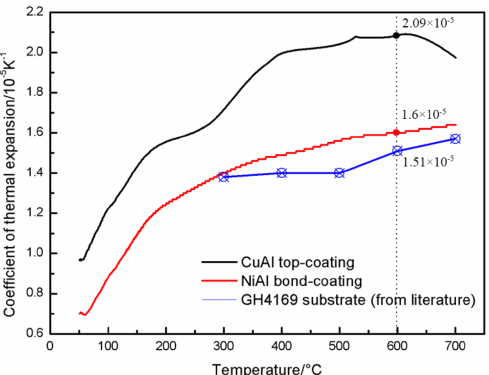
Figure 2. Thermal expansion coefficients of the thermally sprayed CuAl coating, NiAl coating and GH4169 substrate.